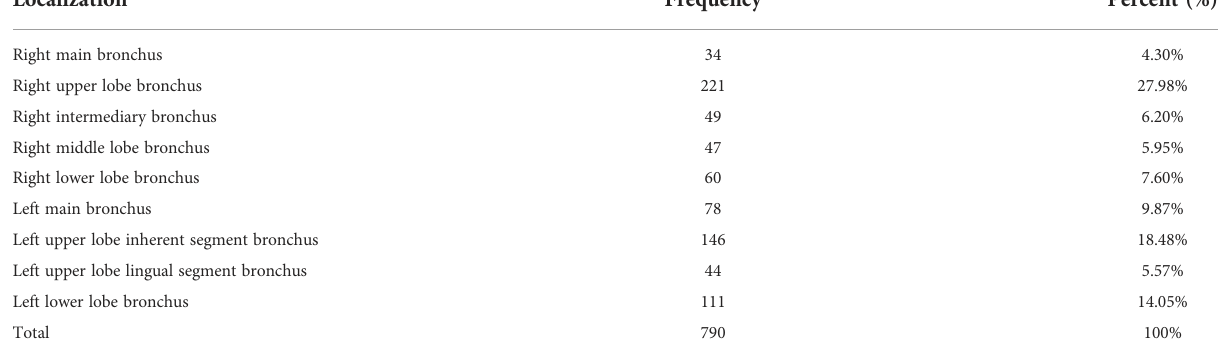
TABLE 2 Localizations of lung cancer under NBI.